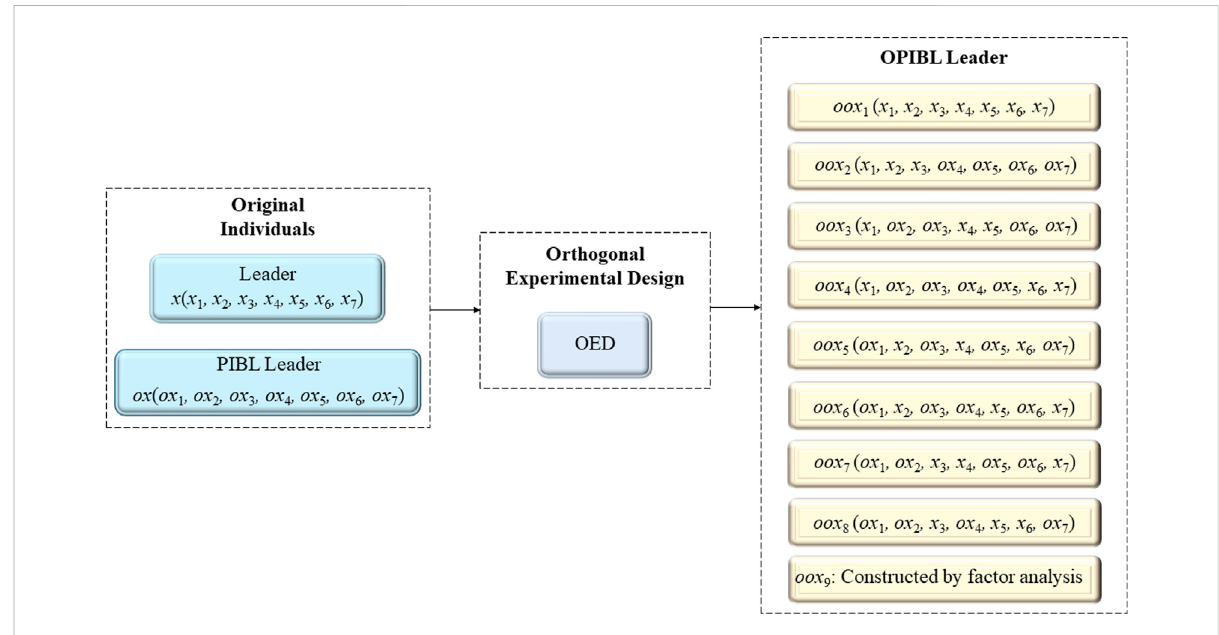
FIGURE 2 Construct OPIBL